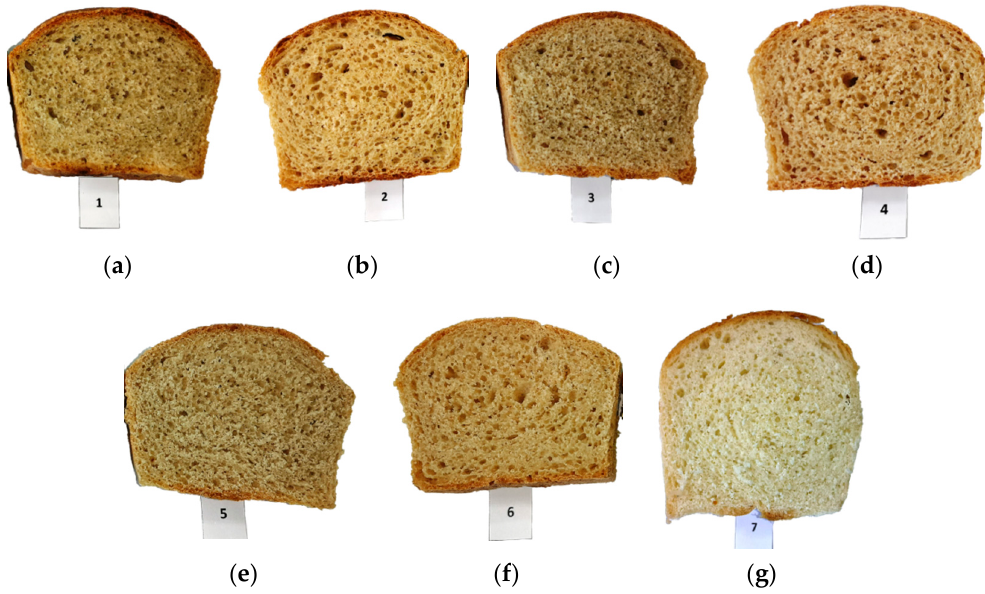
Figure 6. Bread samples (( a ) P1 = 70% wheat + 30% sorghum without L. plantarum ; ( b ) P2 = 70% wheat + 30% sorghum with L. plantarum ; ( c ) 65% wheat + 35% sorghum without L. plantarum ; ( d ) P4 = 65% wheat + 35% sorghum with L. plantarum ; ( e ) P5 = 65% wheat + 35% sorghum without L. plantarum ; ( f ) P6 = 65% wheat + 35% sorghum with L. plantarum ; ( g ) P7 = 100% wheat flour (type 550)–control sample).